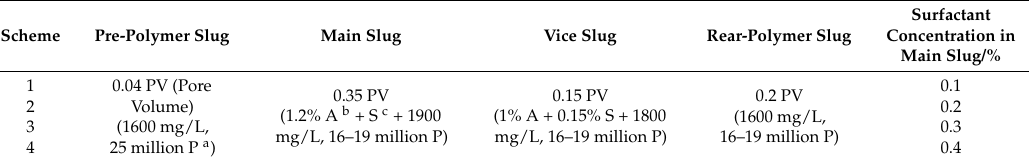
Table 2. Numerical simulation schemes of the oil displacement with different surfactant concentrations in the main slug.